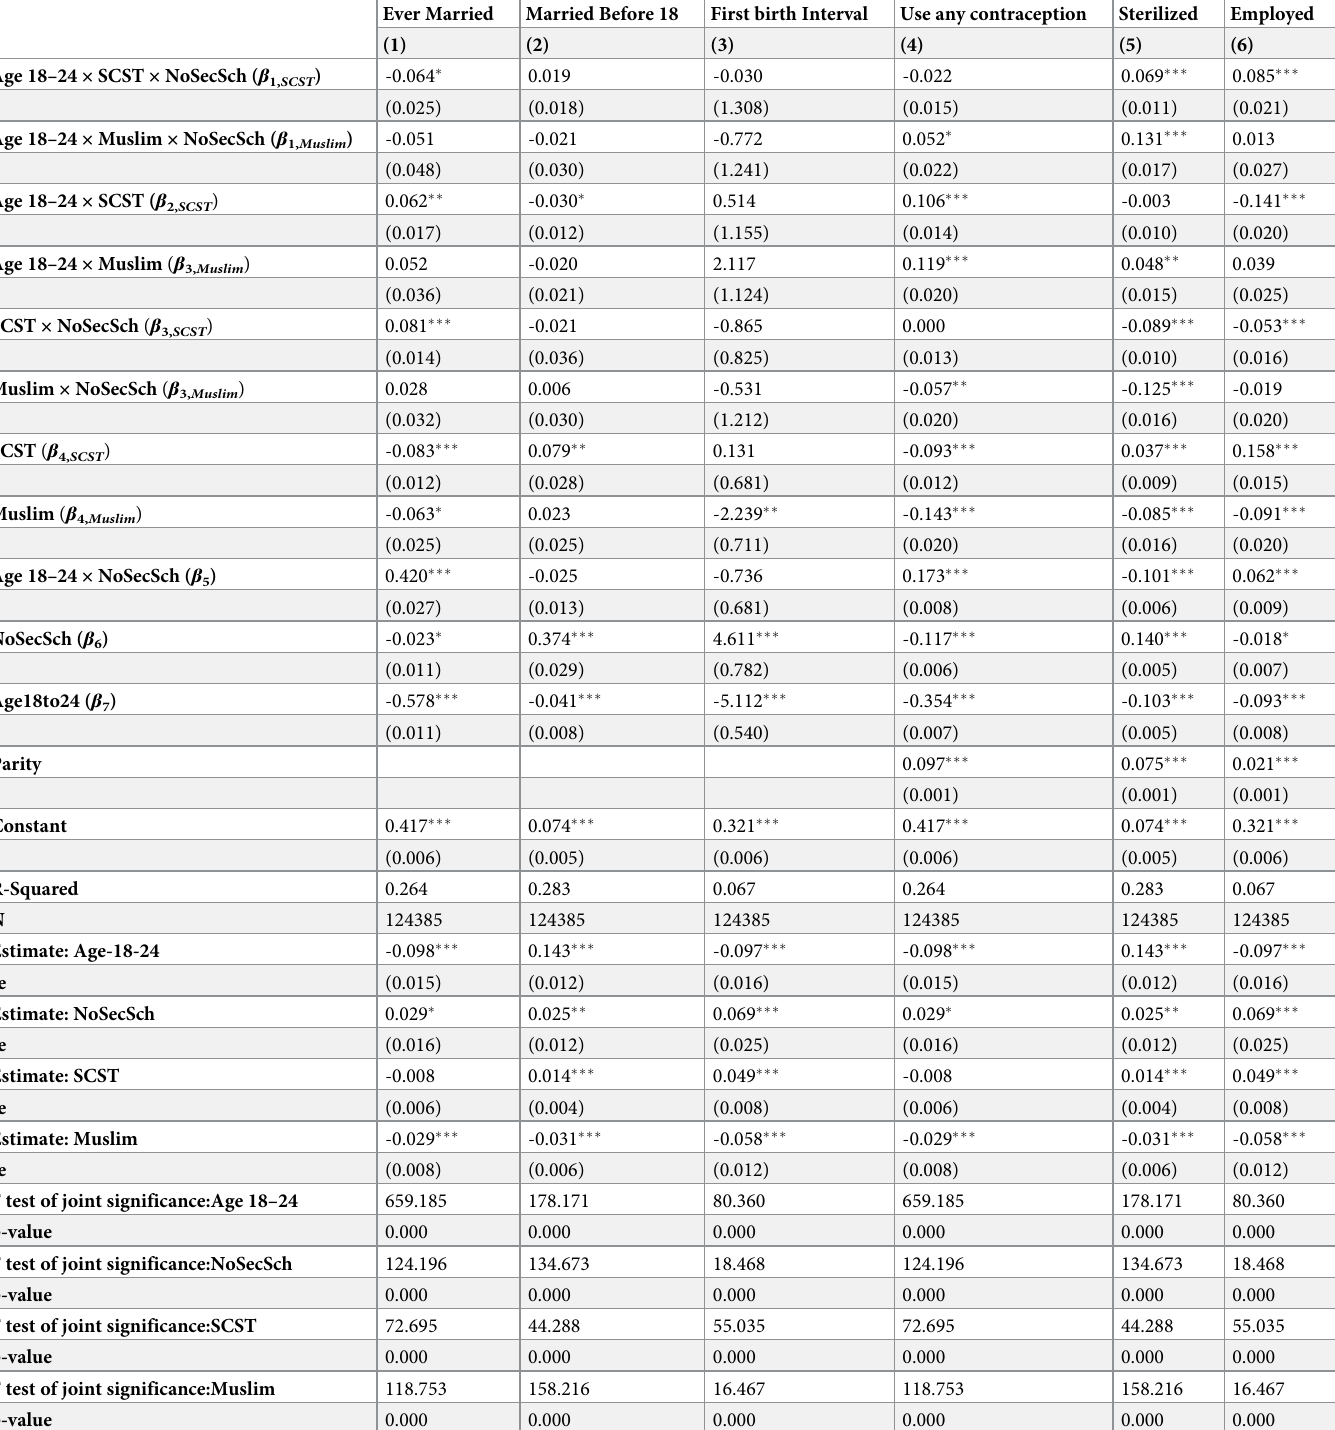
Table 3. Determinants of regression results from NFHS-3. Ever Married Married Before 18 First birth